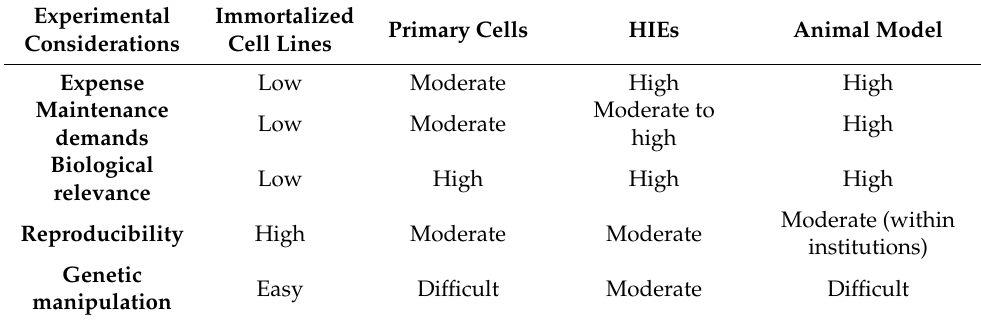
Table 2. Considerations in selection of method(s) for the study the human RNA enteric